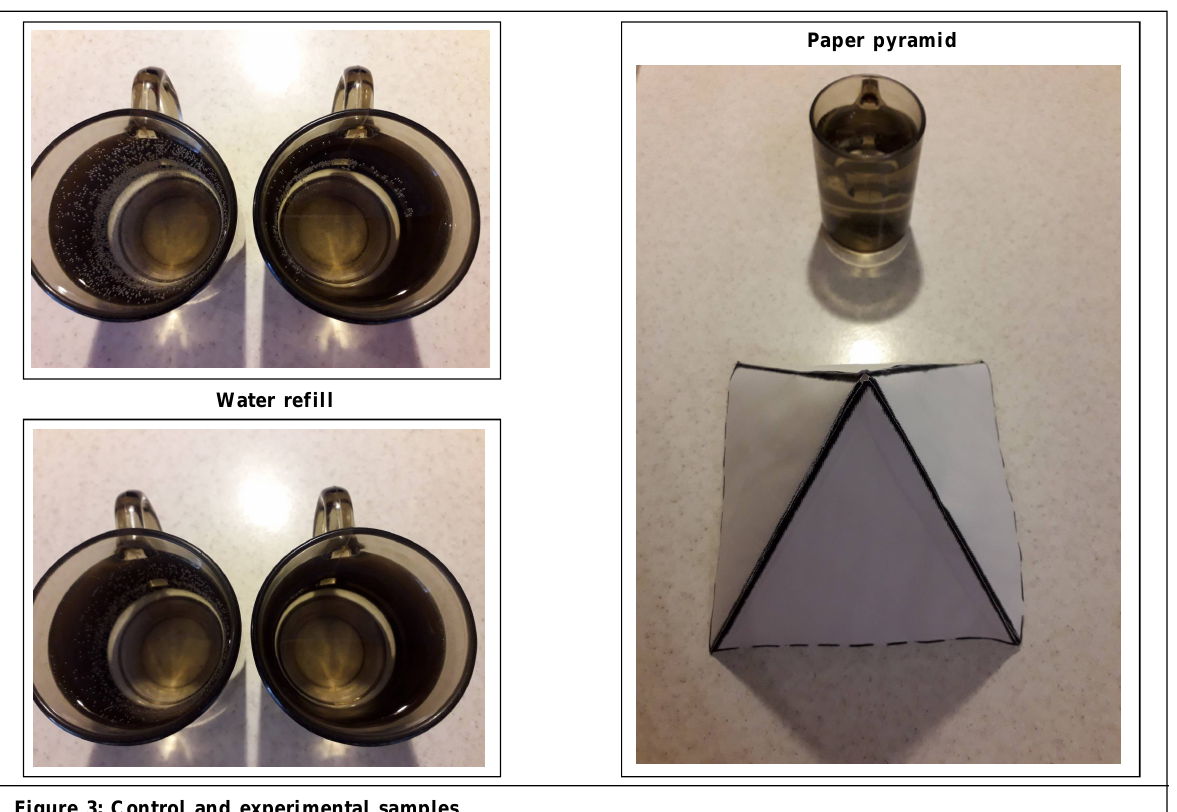
Figure 3: Control and experimental